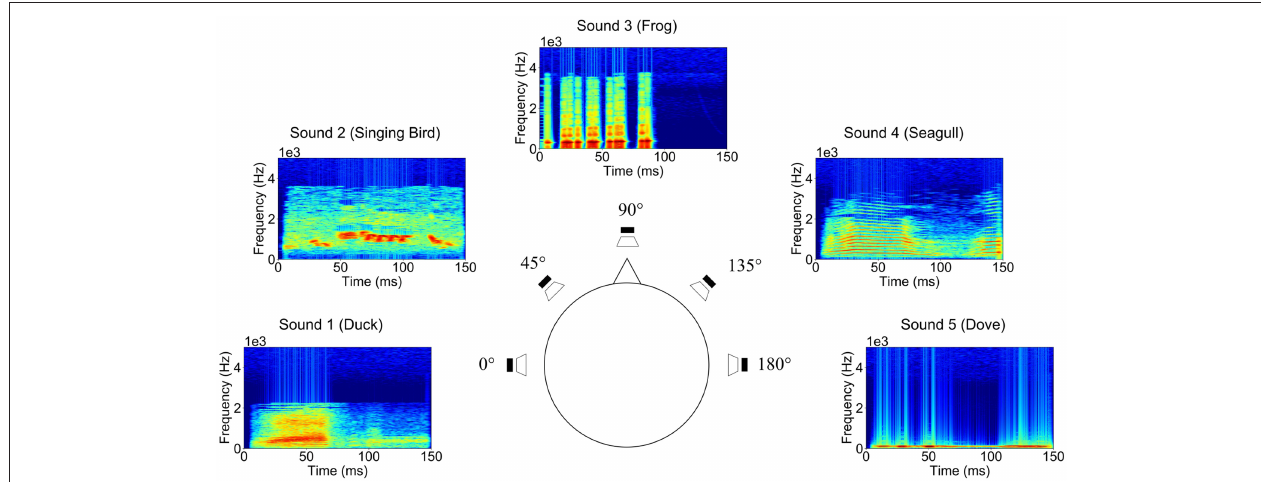
FIGURE 1 | Spectrograms and directions of the five natural sounds (0 ◦ : duck, 45 ◦ : singing bird, 90 ◦ : frog, 135 ◦ : seagull, and 180 ◦ : dove) presented in our experiments.